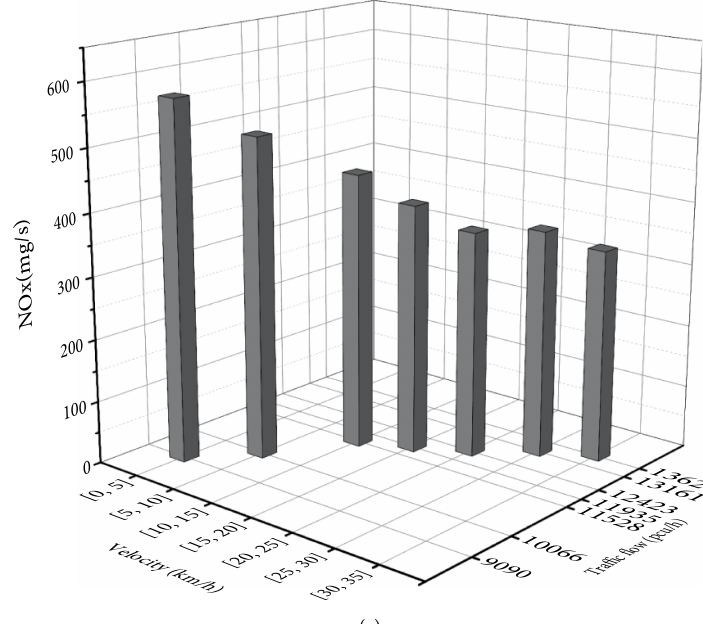
Figure 5: Relationship among emissions, traffic flow and velocity. (a) CO emission analysis. (b) HC emission analysis. (c) NO